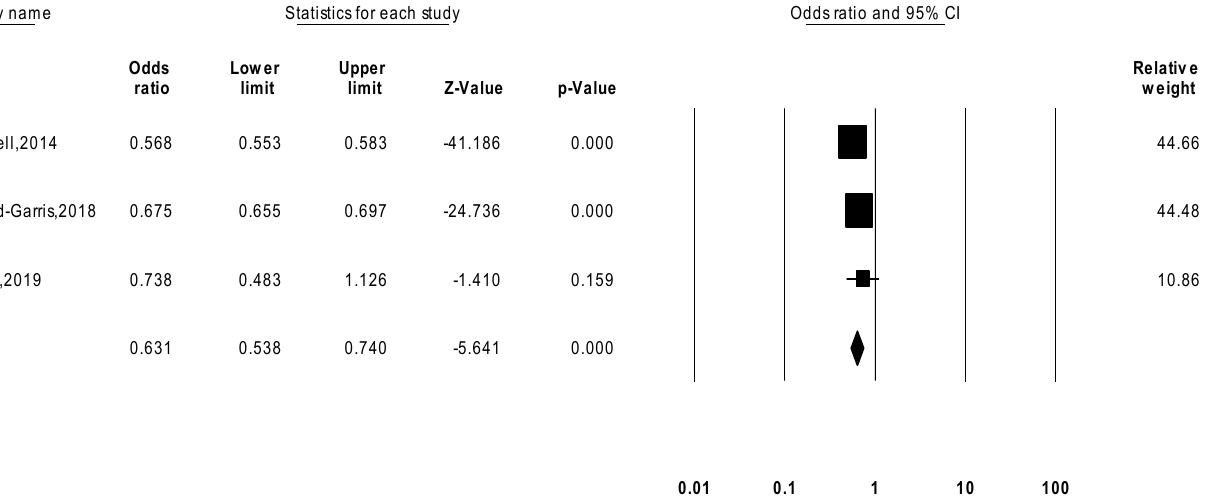
Figure 3. Random effects model for meta-analysis of the likelihood of subjects with ACEs being highly psychologically resilient as compared to those without adverse childhood experiences.